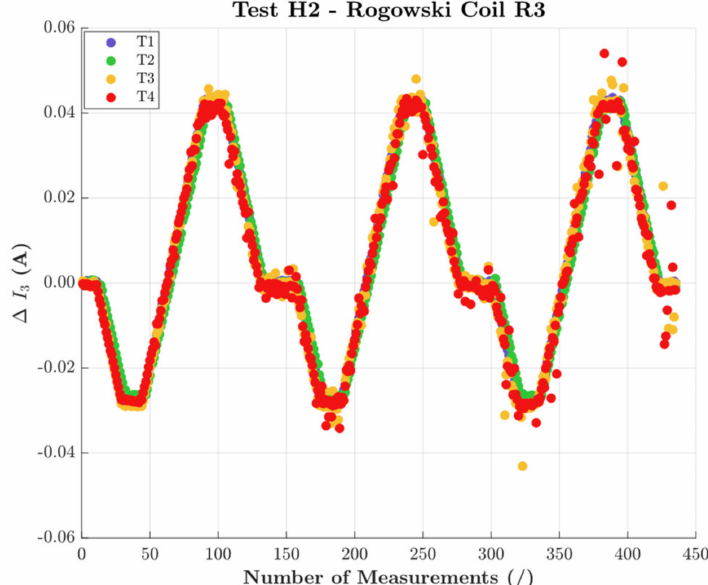
Figure 10. Third harmonic variations obtained with H2 and all positions for